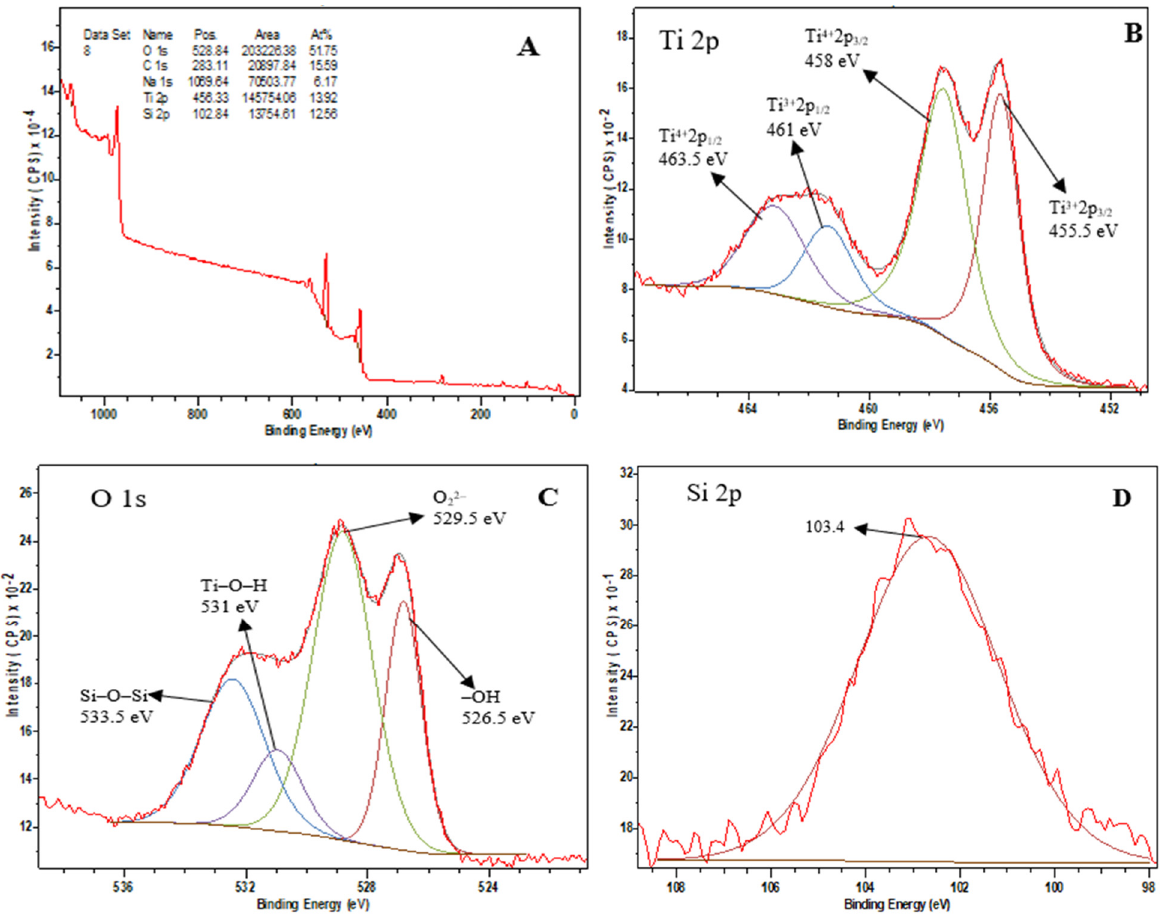
Figure 7. XPS spectrum of T/S 20% ( A ), Ti 2p ( B ), O 1s ( C ), and Si 2p ( D ) composites.